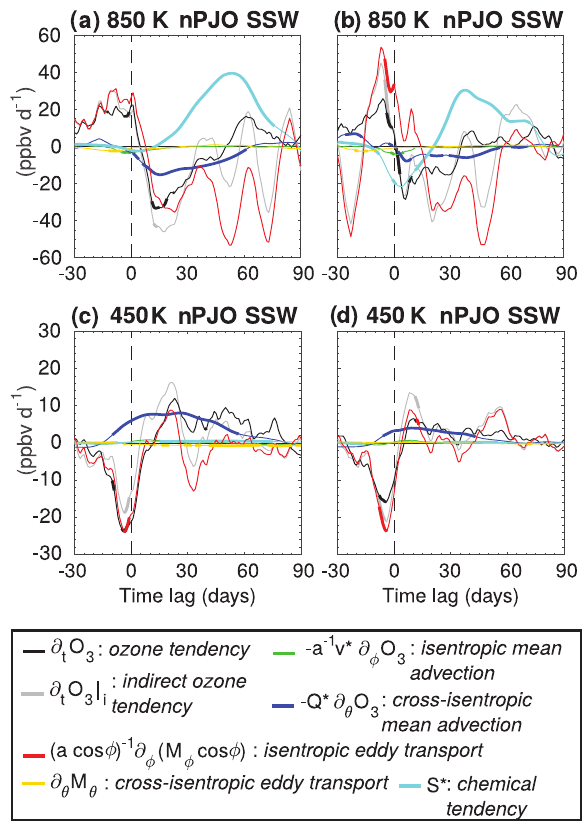
Figure 8. Composite evolution of the anomalies of the different terms in Eq. (1) at 850K and 450K, averaged over 70–90 ◦ N. (a, c) PJO SSW and (b, d) nPJO SSW. Thick lines indicate statistically significant values (two-tailed Student’s t test, α = 0 . 01). WACCM